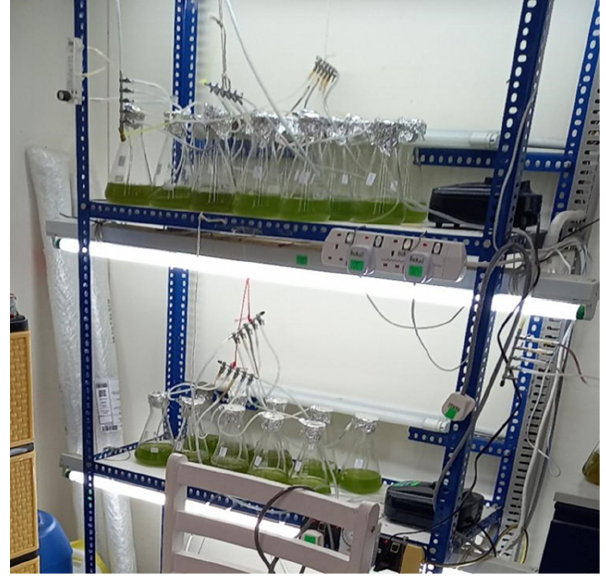
Figure 2. Experimental setup.